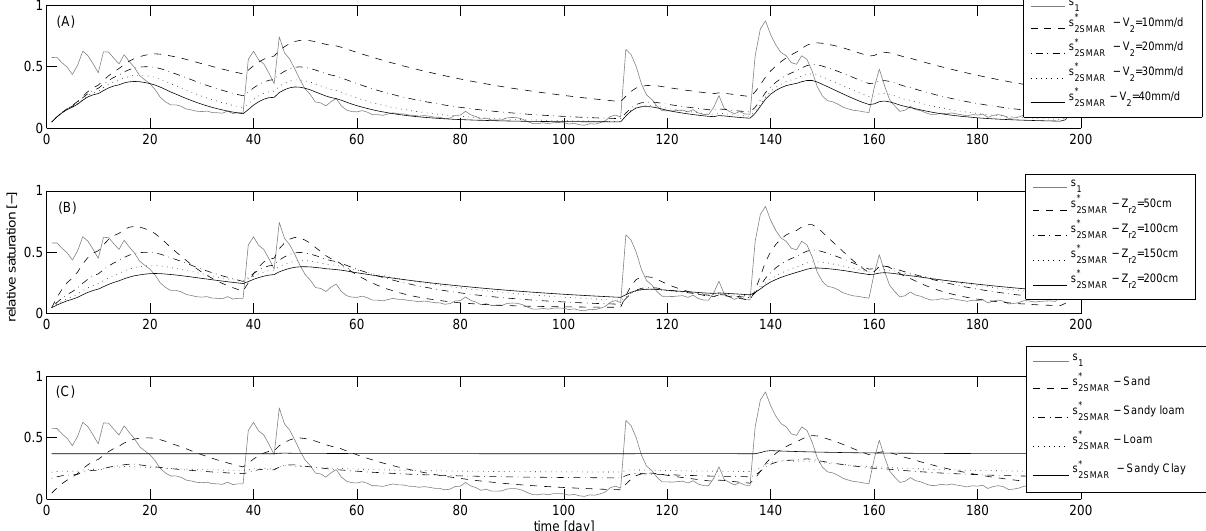
is obtained through changing 2SMAR